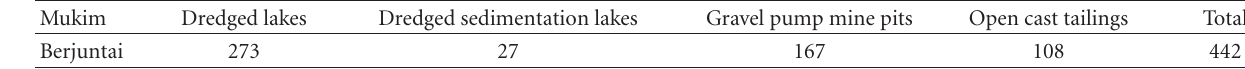
Table 1: Lakes develop after di ff erent mining operations [33].